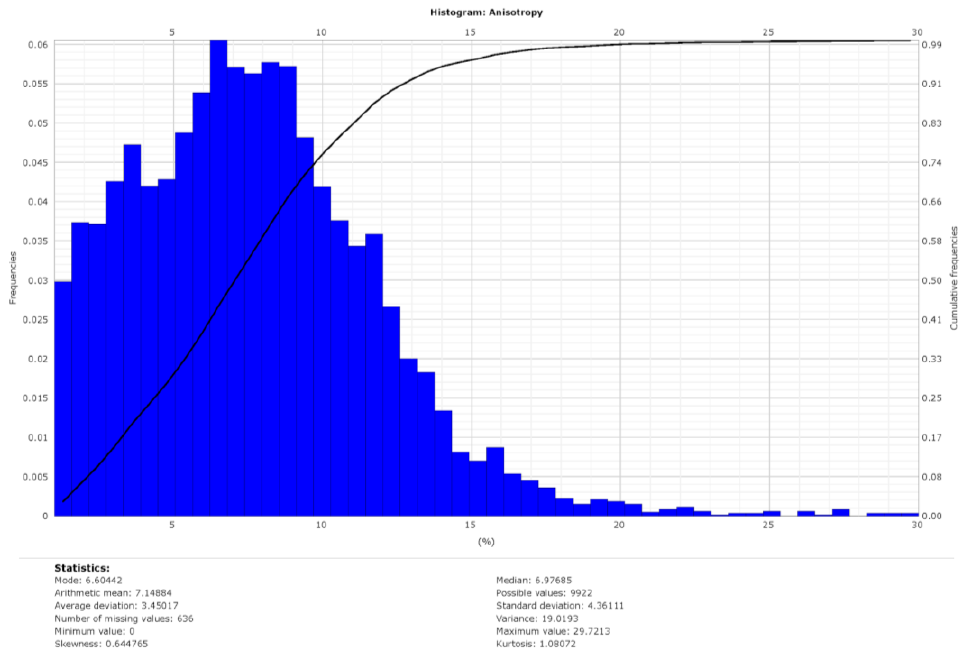
Figure 4. Histogram of absolute value of percent anisotropy (using Equation (1)) over the study well (x-axis), frequencies (left y-axis) and cumulative frequencies (right y-axis and black curve). Most shales have anisotropy greater than 5%.